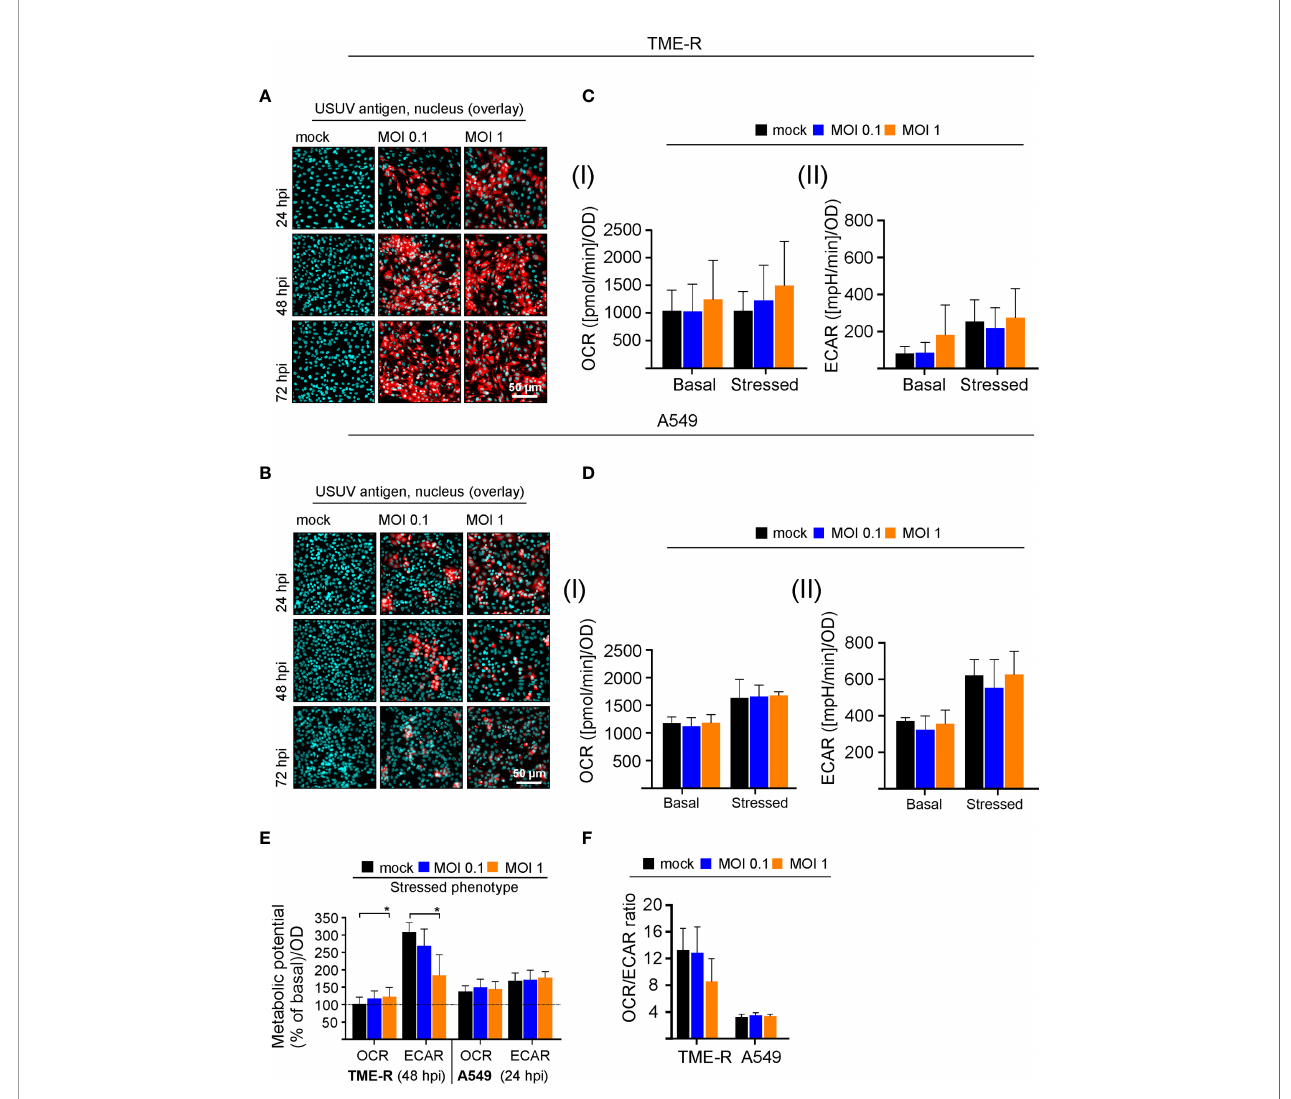
FIGURE 3 | Analysis of the cell-type speci fi city of USUV infection rate and the associated metabolic impact. (A, B) The onset of maximum rate of infected cells was determined by immuno fl uorescence analysis for (A) TME-R and (B) A549 cells with pan- fl avivirus antibodies for low (MOI 0.1) and high (MOI 1) infectivity rate (representatively shown in red for n = 3 with nuclear counterstain in blue). (C) At 48 hpi for TME-R and (D) at 24 hpi for A549 cells mitochondrial respiration based on (I) OCR values and glycolysis based on (II) ECAR values were determined through extracellular fl ux measurements under basal (without treatment) and stressed conditions (co-application of 0.8 µM FCCP and 1 µM oligomycin). (E) The metabolic potential was determined through the percent increase in stressed OCR and ECAR over basal OCR and ECAR. (F) OCR/ECAR ratio was calculated based on basal OCR and ECAR as determined at measurement point 3 of extracellular fl